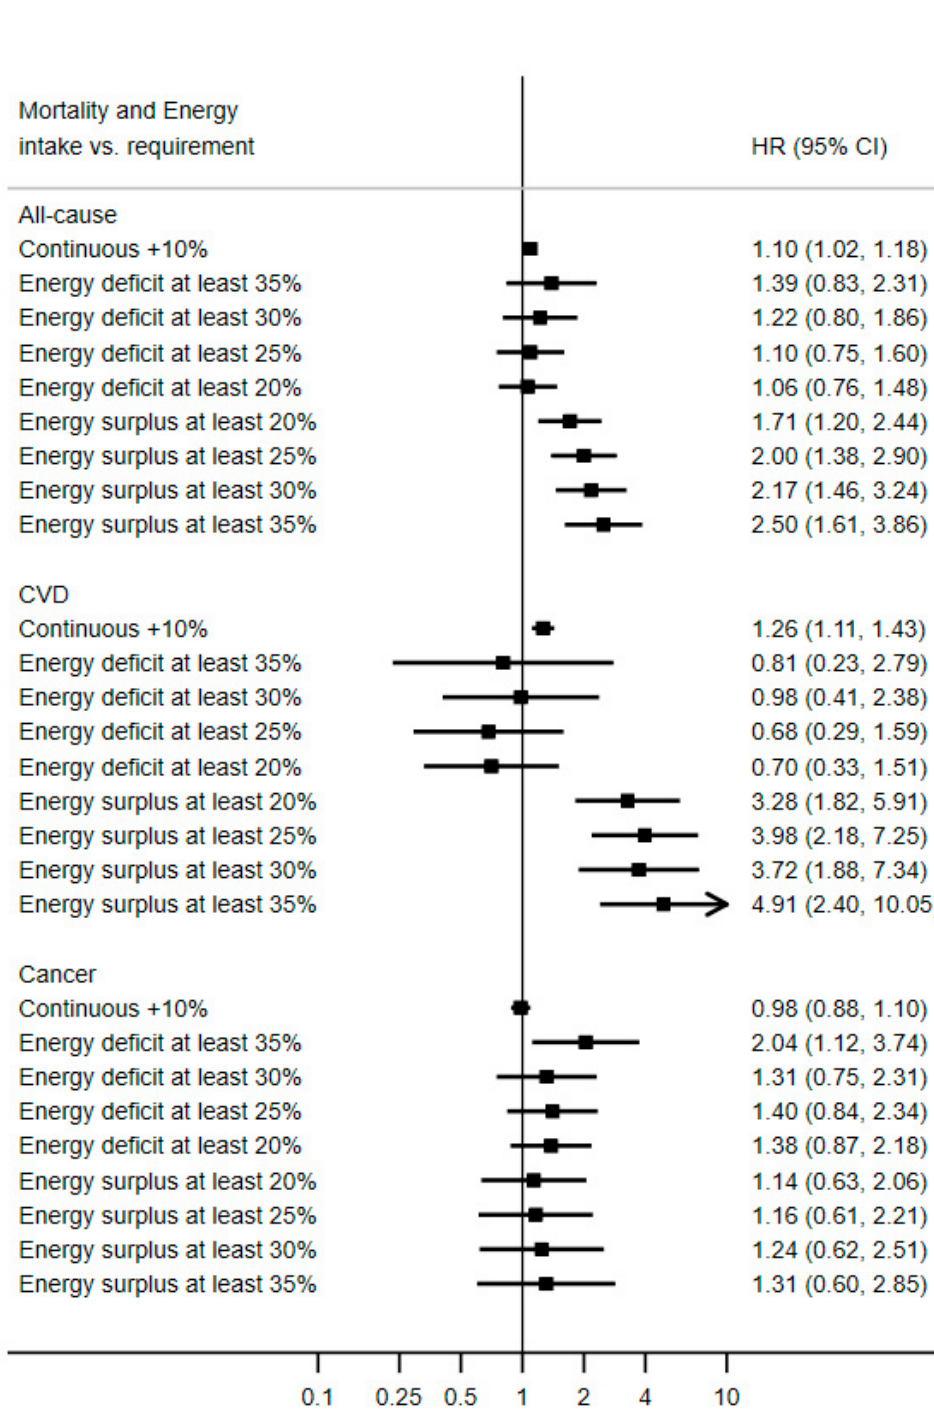
Figure 2. Association between long-term ratio of energy intake to theoretical energy requirement and mortality risk, PREDIMED study, N = 7119. Values are multivariable hazard ratios (HRs) and 95% confidence intervals, stratified by sex, study center and education level, and adjusted for baseline age, intervention group, hypertension, hypertriglyceridemia, hypercholesterolemia, diabetes, alcohol intake, smoking status and cumulative average of Mediterranean diet score. Energy deficit is defined as energy intake below energy requirement. Energy surplus is defined as energy intake above energy requirement.